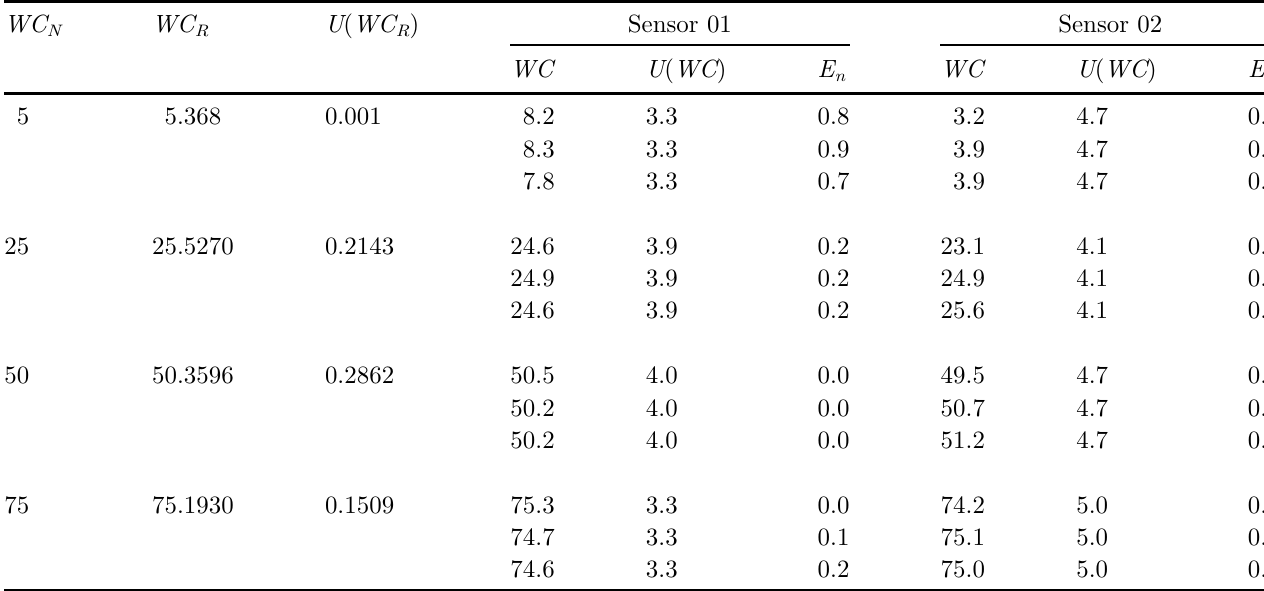
Fig. 4. Differences between literature values and the mean thermal conductivity for sensor 02. Table 9. Comparison of the measurements of WC of the binary samples (in % water).